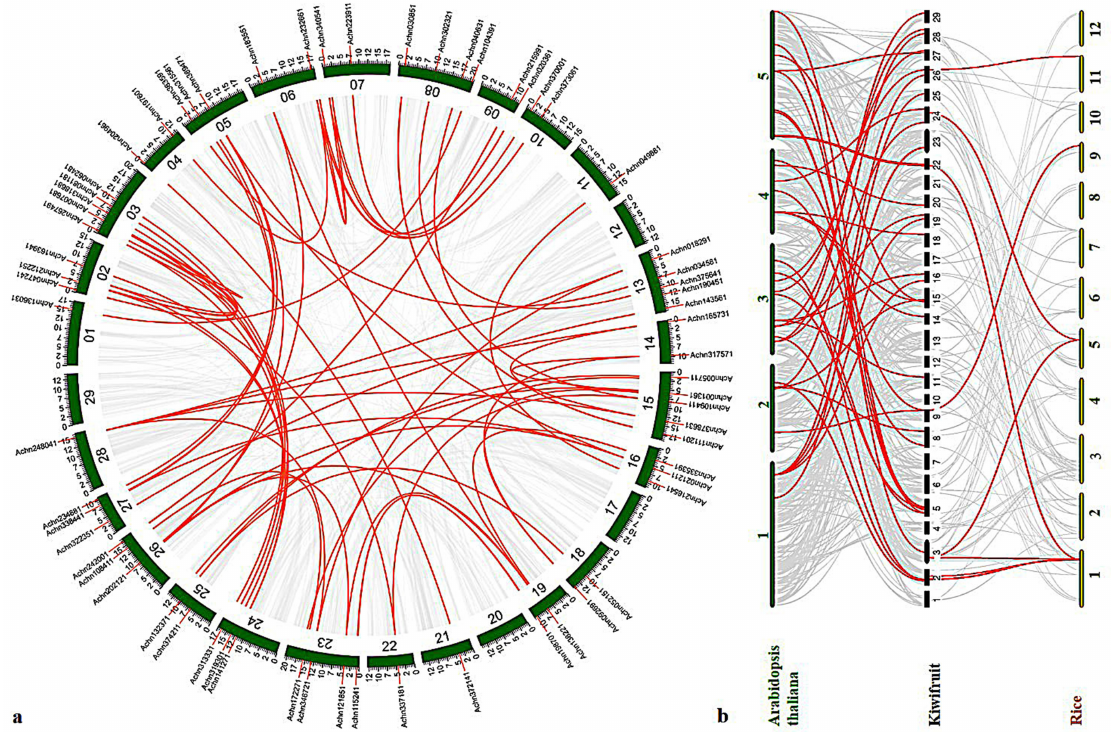
Figure 4. Collinearity analysis of AcMYBs TF in kiwifruit. ( a ) Collinearity analysis and gene dupli- cation in kiwifruit genome. The gray line represents all autosomal blocks in kiwifruit genome, the red line represents the AcMYB gene duplication events, and the AcMYB gene is represented by a vertical red line. ( b ) Collinearity analysis of kiwifruit and two model plants; the green chromosome is Arabidopsis thaliana , and the yellow chromosome is rice.